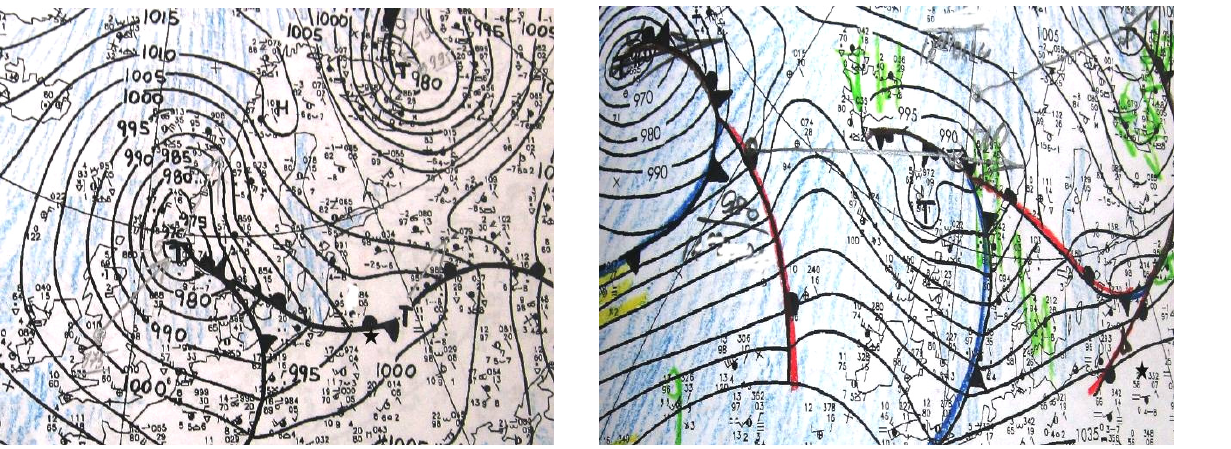
Fig. 12. 23 Oct. 2002 14 h. No HCRF decease. Cyclone Fig. 15. 26 Jan. 2003 14 h. No HCRF decrease.